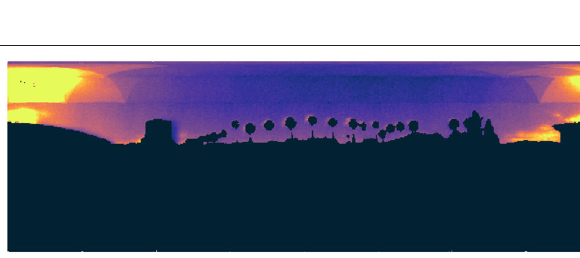
FIGURE 4 | Demonstration of pixel categorization at Hayden Lawn on summed longwave and shortwave irradiance image where pixels classified as “ground” are blacked